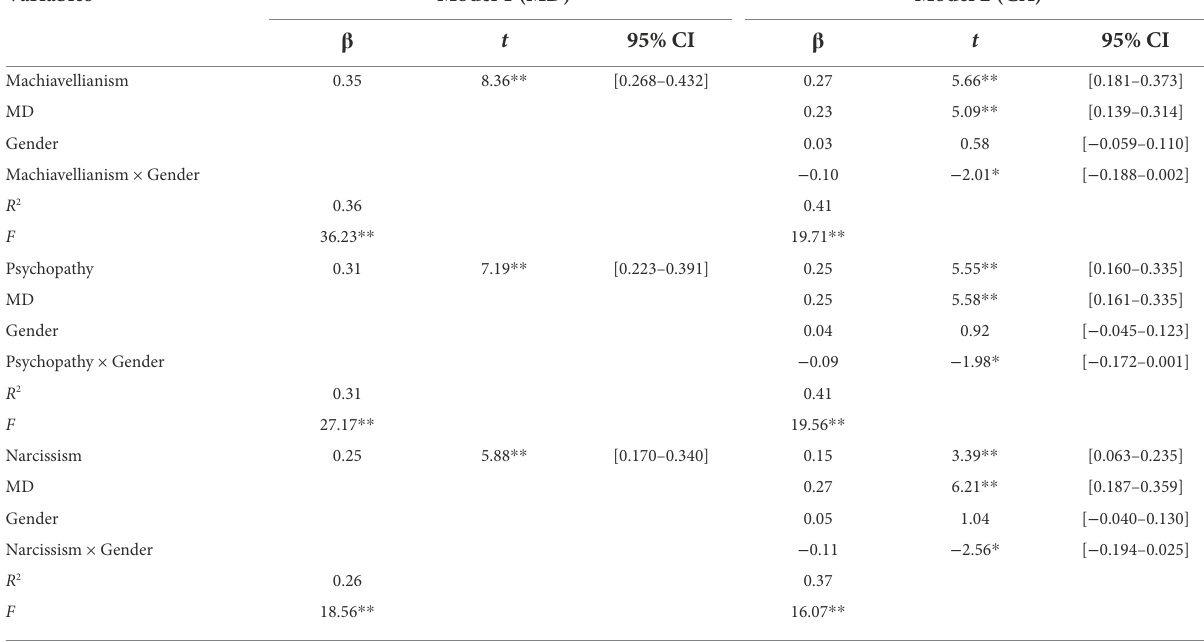
TABLE 4 Testing the moderated mediation model ( N =